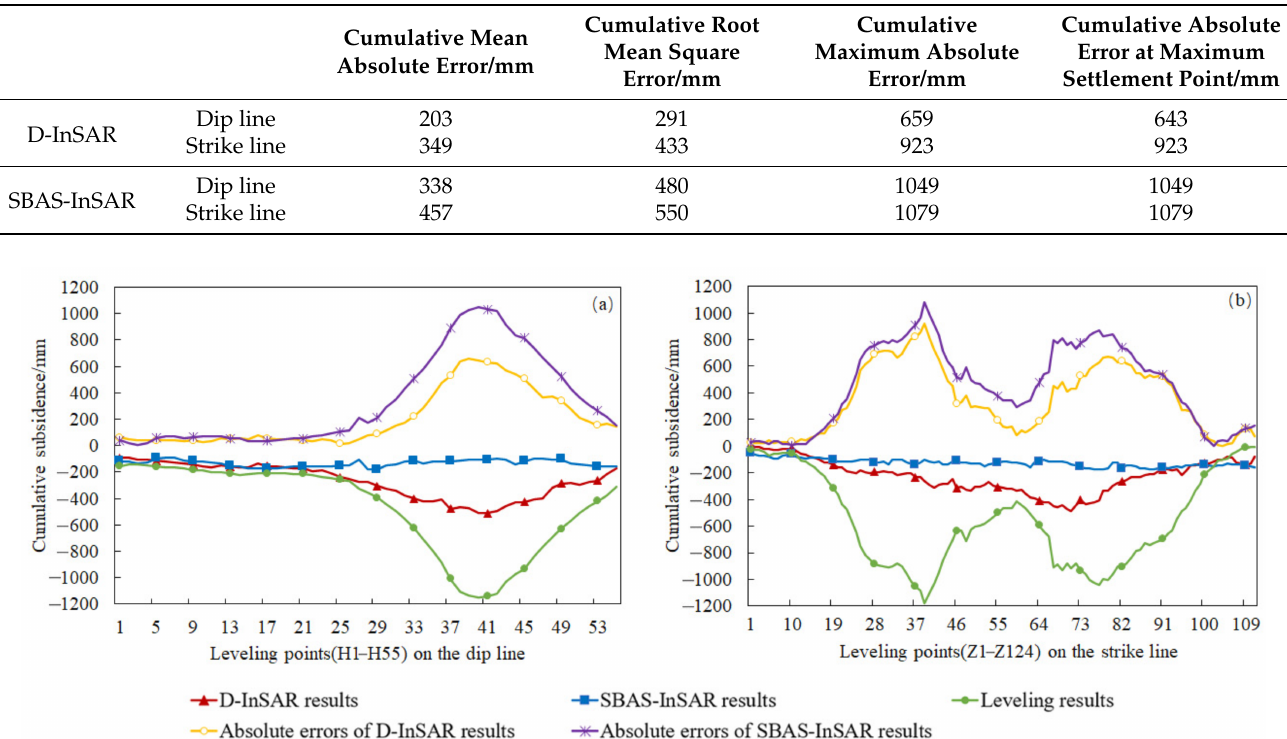
Figure 6. Layout of leveling observation points. Table 3. The error statistics of InSAR-monitored results.